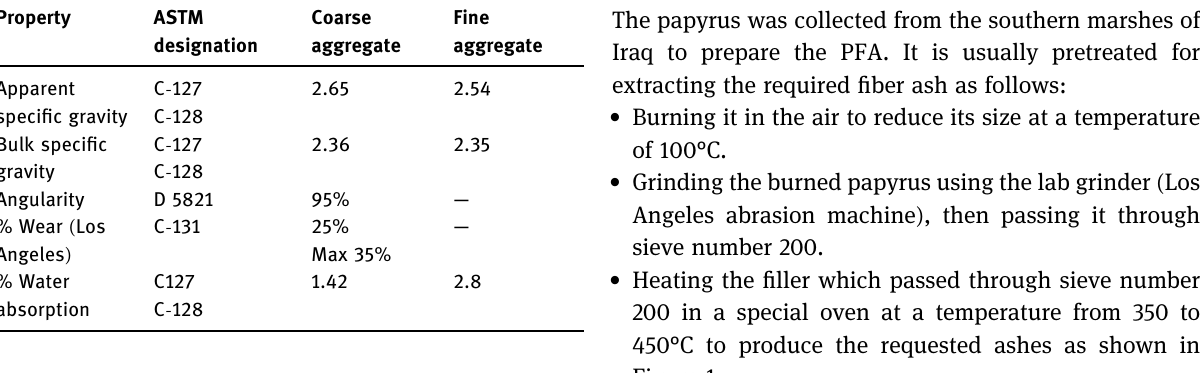
Table 3: Asphalt mixture grading